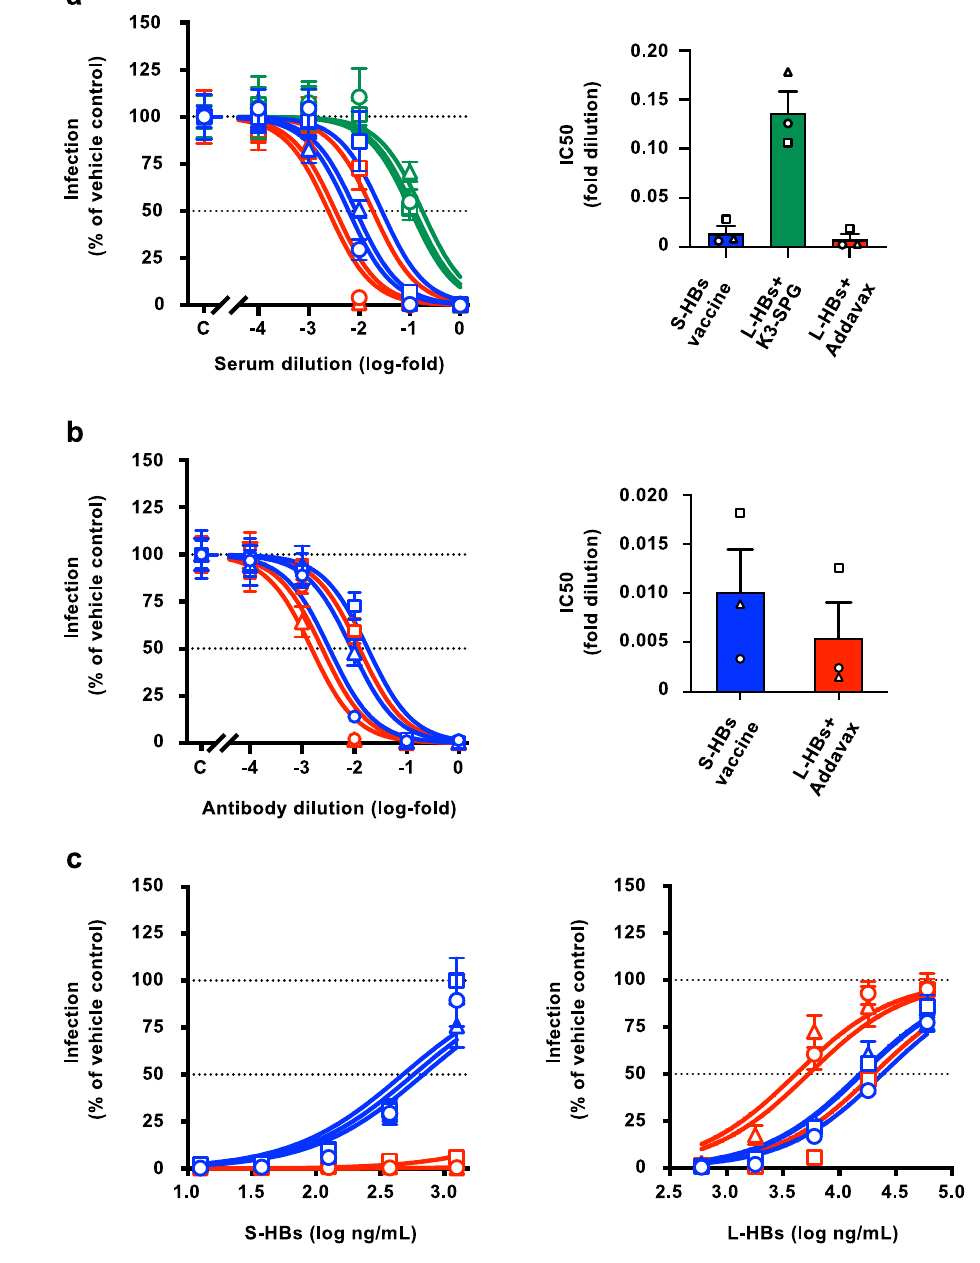
Fig.3|NeutralizingactivitiesintheHBV/NLinfectionsystem.a Theneutralizing activitiesof serum samples were assessed inthe HBV/NL-WT infection system. The cell culture-generated HBV/NL-WT (GTC, 20 GEq/cell) was mixed with serially dilutedserumsamplesofrhesusmacaquesimmunizedwithS-HBsvaccine(blue),L- HBs+K3-SPG (green), or L-HBs+Addavax (red) for 1h at 37°C and infected into G2/ NT18-C cells. The infection ef fi ciencies at the indicated dilutions of serum were assessed by measuring the NL activities of infected cells in 5 wells at 7 days after infection and the mean±SD was indicated at each dilution. The dose – response curves with thelog(inhibitor) vs. normalized response model weredrawn, and the IC 50 values were calculated. The mean±SE of IC 50 values of three animals is indi- cated in the right panel. b The neutralizing activities of puri fi ed antibodies were assessed in the HBV/NL-WT infection system. HBV/NL-WT (GTC, 20 GEq/cell) was mixed with serially diluted antibodies induced in S-HBs vaccine- (blue) or L-HBs +Addavax- (red) immunized macaques for 1h at 37°C and was used to infect G2/ NT18-Ccells.Theinfectionef fi cienciesattheindicateddilutionsofantibodieswere